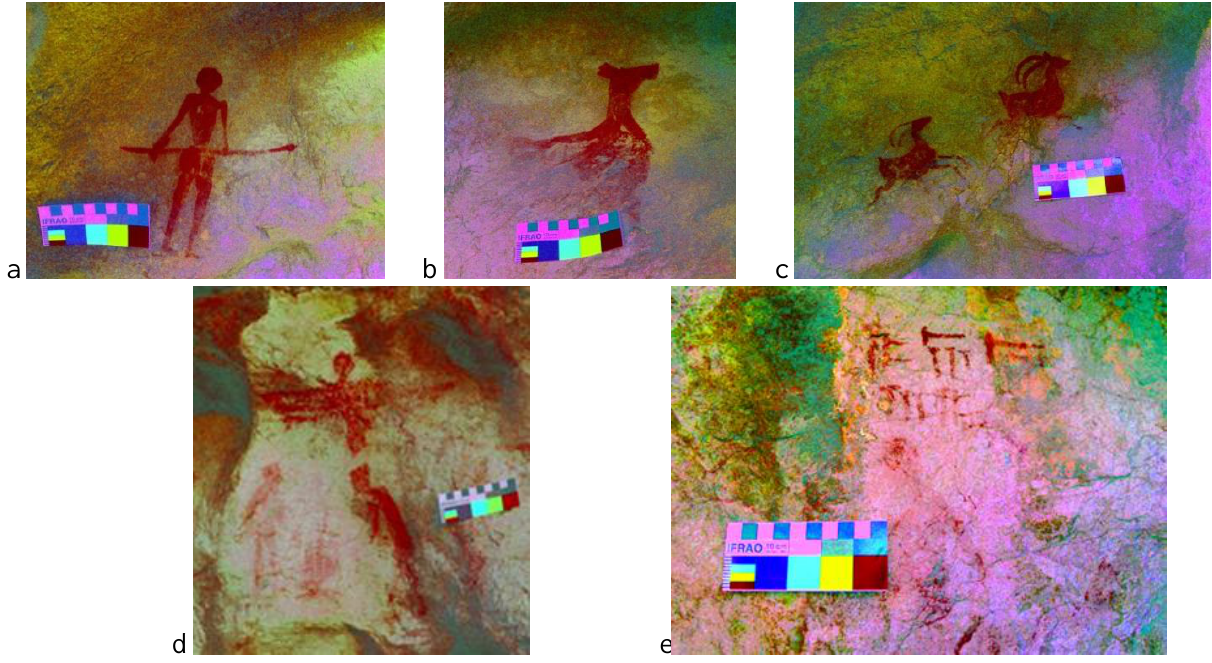
Figure 3. Depictions from Site I: ( a ) Human shape with a stick-like figure in the hands. ( b ) An unknown zoomorph. ( c ) “ibexes”. ( d ) Anthropomorphs with an unknown shape resembling Farvahar above the scene. ( e ) A cuneiform inscription with an anthropic depiction below the scene. (All photographs enhanced using